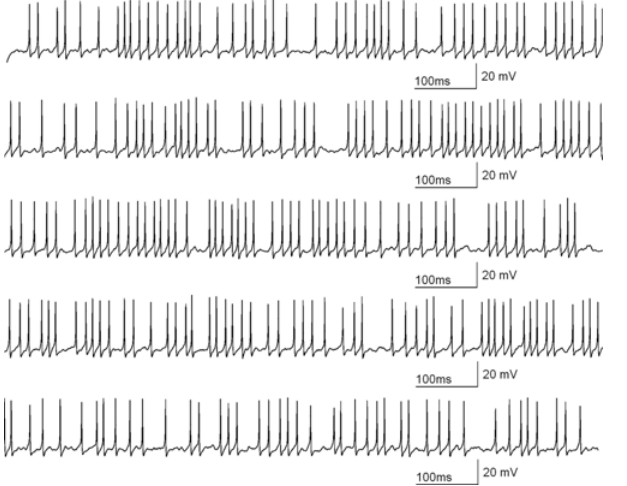
Figure 7. Example of stable, long-lasting, continuous simula- tion with irregular firing using the stochastic model. A depolarizing current pulse just above the firing threshold is given. A simulation of 5 seconds is shown to provide evidence that stable solutions are obtained with stochastic differential equations and Brownian motion. The simulation time of this trace with time-step of 10 2 5 seconds is ca. 15 seconds. For this simulation s =0.5.